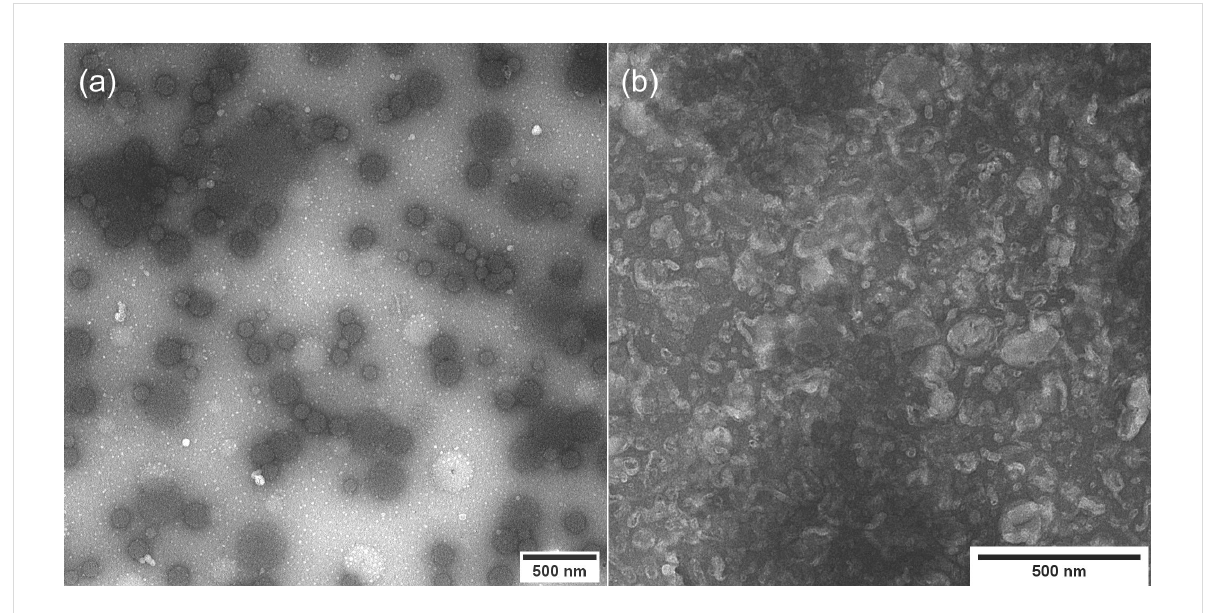
Figure 1: TEM images of PHEG-Tyr (a) and N α -Lys-NG (b) nanogels prepared by HRP/H 2 O 2 -mediated crosslinking in inverse